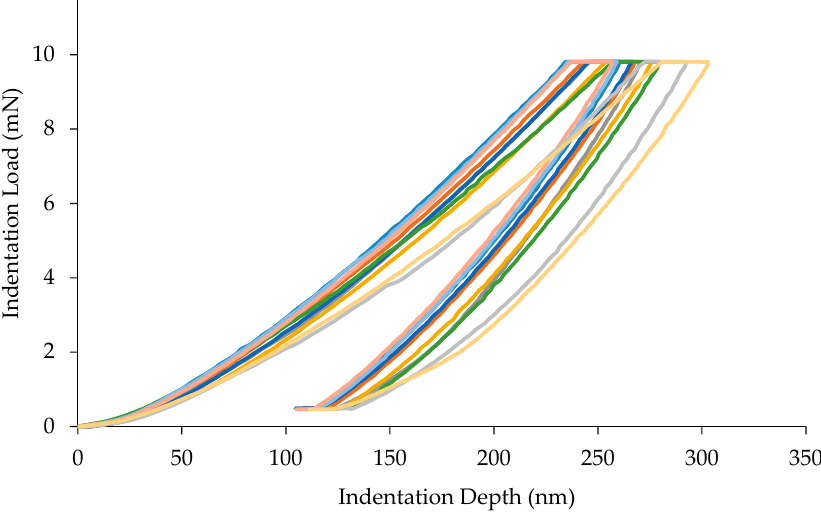
Figure 6. Load-displacement curve for 10 indents on aggregate phase.